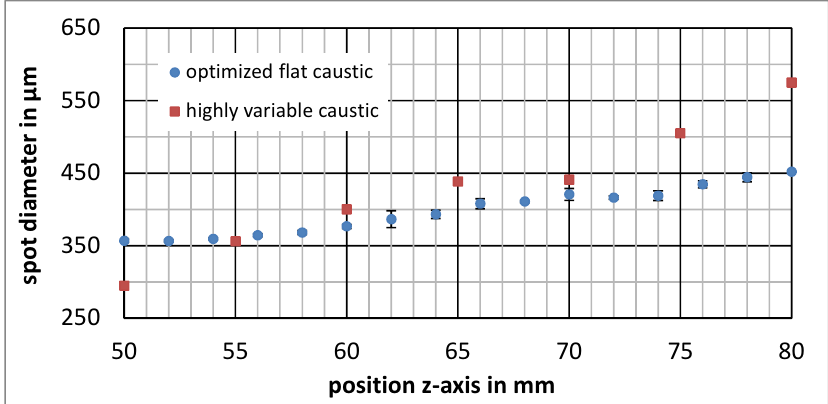
Figure 6. Beam caustic comparison: average diameter of an individual laser point in the grid with respect to the position beneath the tip of the